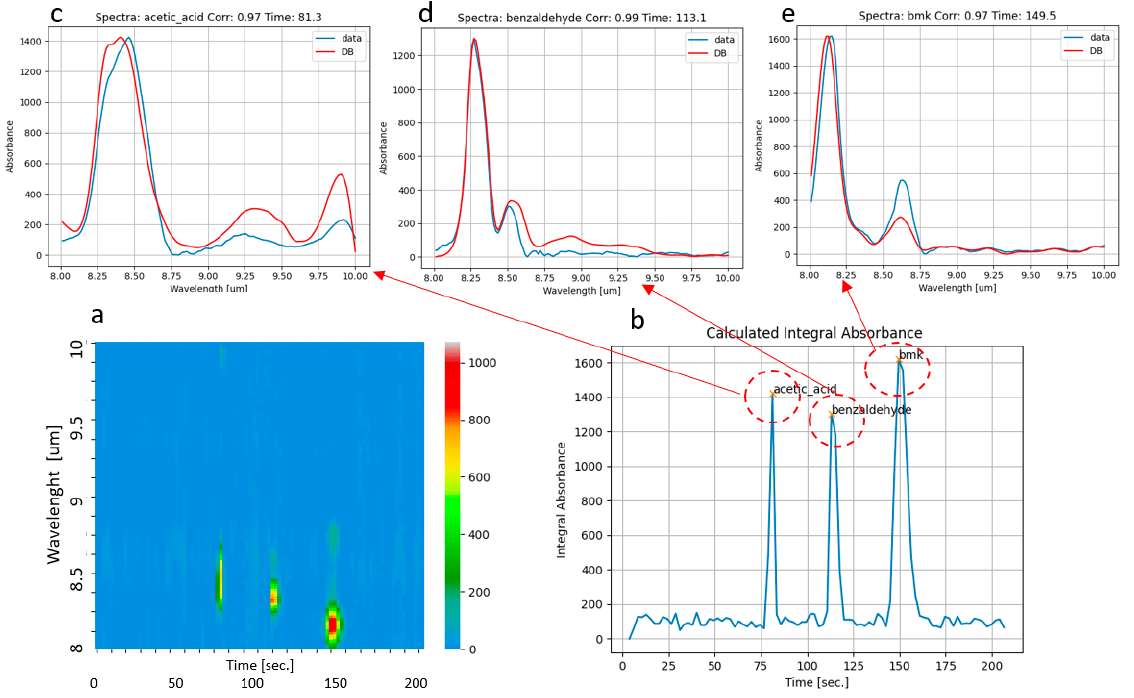
Figure 9. Analysis of BMK. (a): color map obtained as described in Figure 8; (b): the corresponding total absorption chromatogram; (c), (d), and (e): spectra acquired at ca. 80 s, 115 s, and 150 s, allowing one to identify acetic acid, benzaldehyde, and BMK, respectively.